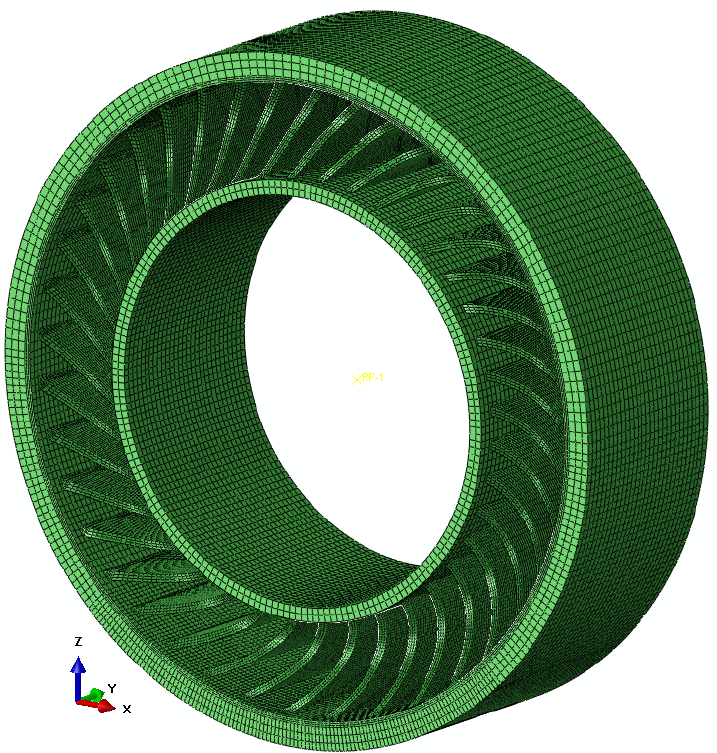
Figure 4. The finite element model of the